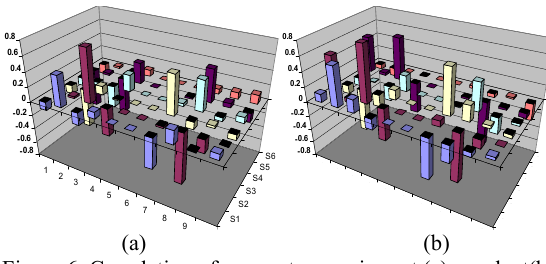
Figure 6. Correlation of parameters, main part (a),